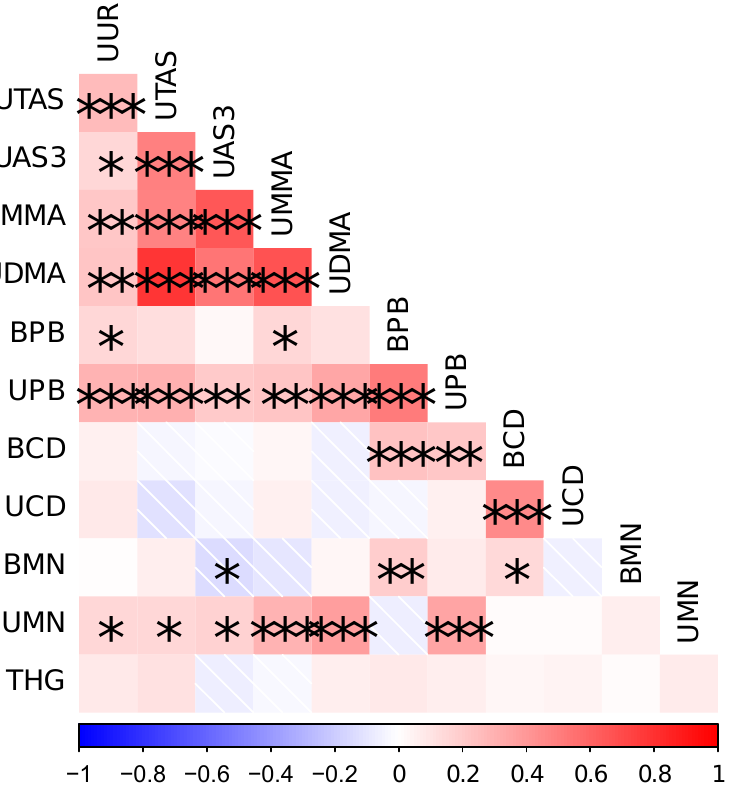
Figure 2. Spearman’s correlations between metal biomonitoring results. Correlation coefficient is designated by color with blues designating negative correlations and reds designating positive correlations. Asterisks denote significant correlations at the p < 0.05 (*), 0.01 (**), and 0.001 (***).